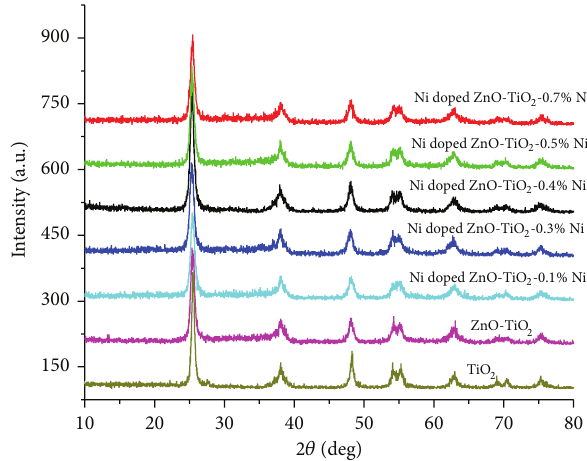
Figure 1: XRD patterns of TiO 2 , ZnO-TiO 2 , and Ni doped ZnO- TiO 2 photocatalysts.